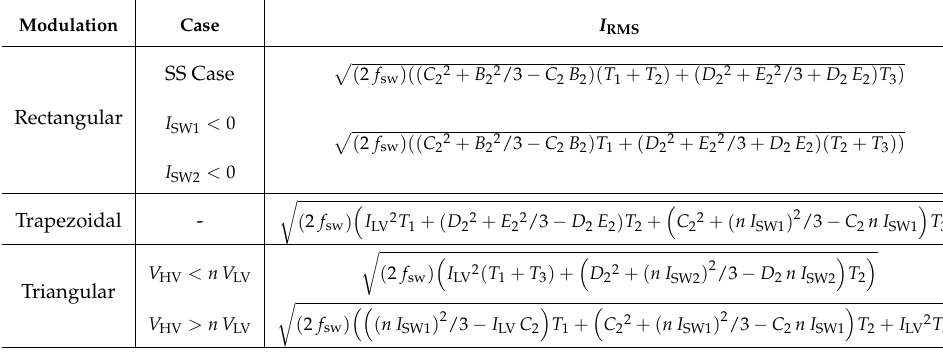
Table A3. RMS Current in output capacitor (power transfer from HV to